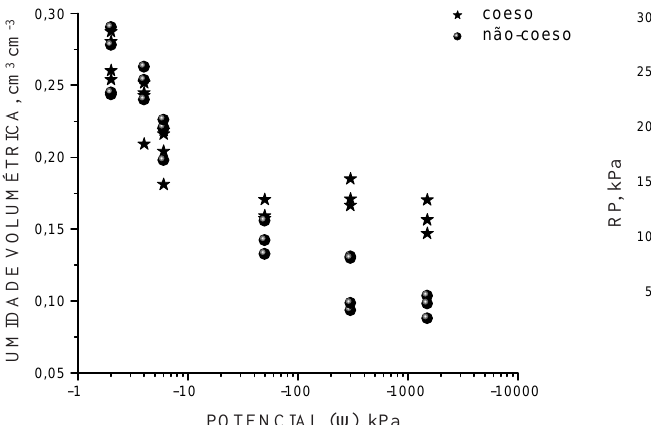
Figura 2. Potencial matricial de água no solo ( yyyyy ) versus umidade volumétrica nos horizontes: coeso e não-coeso.